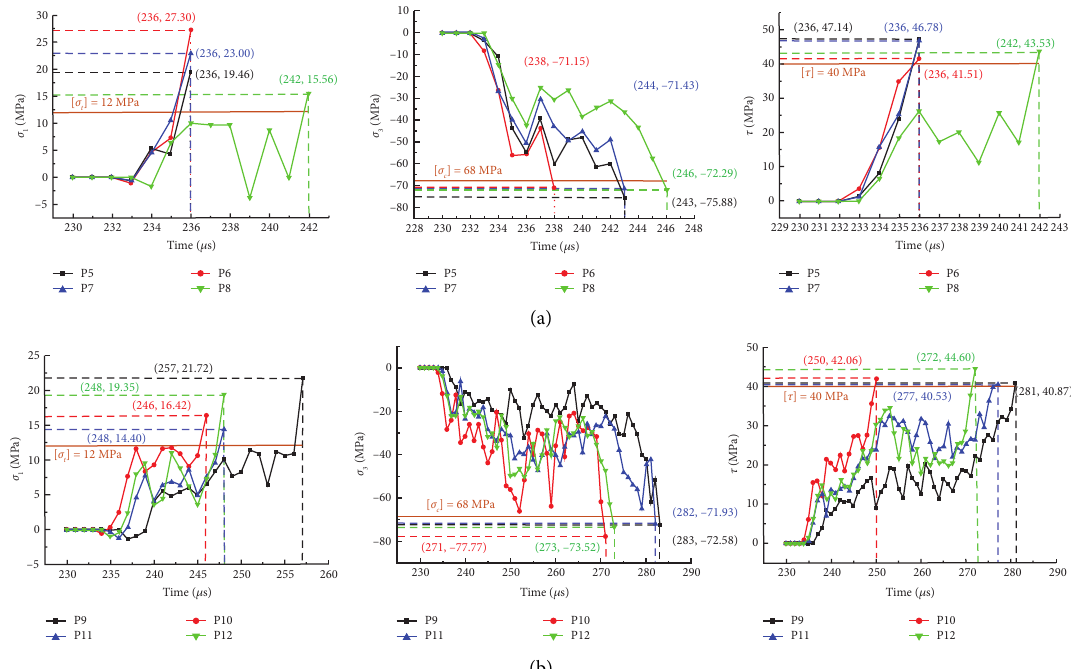
Figure 9: Stress variation curves of rock particles versus time. (a) Crack formation zone. (b) Crack expansion